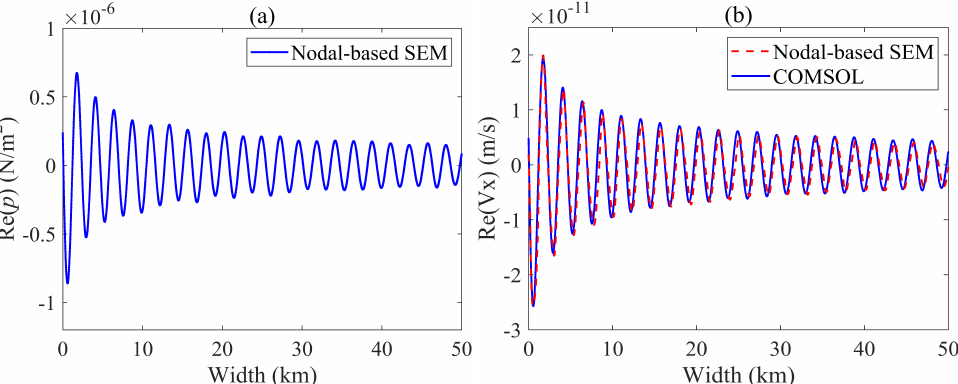
Figure 3. Pressure and velocity values on detectors at a depth of 500 m underwater. ( a ) Pressure curve calculated using nodal-based SEM. ( b ) Velocity curves calculated using nodal-based SEM and COMOSL.